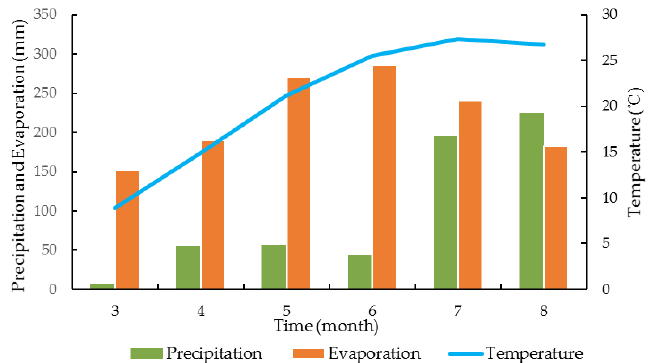
Figure 4. Statistics of monthly average precipitation, evaporation and temperature in the study area from March to August.